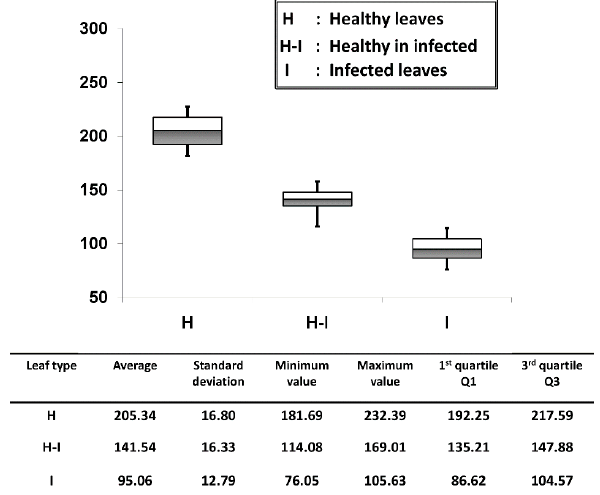
Figure 6. Average palisade parenchyma layer thickness fluctuation of each leaf category. The table depicts all the statistical values and quantifications related to the graph.